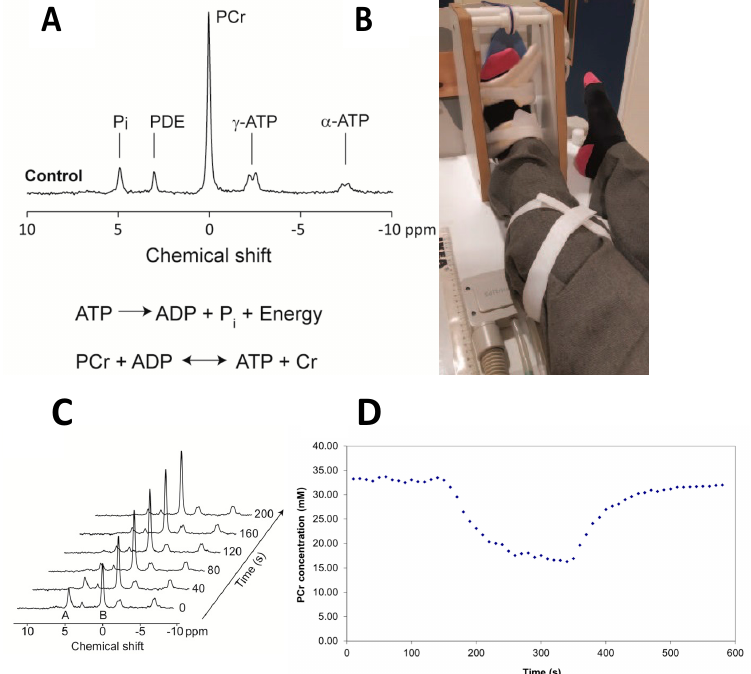
Figure 1. ( A ) The phosphorus spectrum of the human gastrocnemius/soleus muscle at rest, showing the resonances due to inorganic phosphate (Pi), phosphodiesters (PDE), phosphocreatine (PCr) and the α and γ phosphorus nuclei of ATP. The area under each peak indicates the concentration of that substance. ( B ) The apparatus used for the plantar flexion exercise showing the pedal, and the radiofrequency coil used to acquire signals from phosphorus-containing high energy compounds from the back of the leg during exercise and recovery. The pedal is attached to a weight within the scanner bore to provide a fixed resistance of 35% of the maximum voluntary contraction of the subject. ( C ) A dynamic series of phosphorus spectra acquired after the plantar flexion exercise has ceased, showing the changes in the inorganic phosphate peak and the phosphocreatine peak, which recovers to equilibrium. ( D ) Extracting the area under the curve of the phosphocreatine peak for each time point as concentration, showing the initial concentration at rest, depletion during the exercise and recovery by oxidative phosphorylation after exercise has ceased. The τ 1 / PCr is calculated by fitting a 2 monoexponential curve to the recovery. In this case, the τ 1 / PCr was 33.2 2